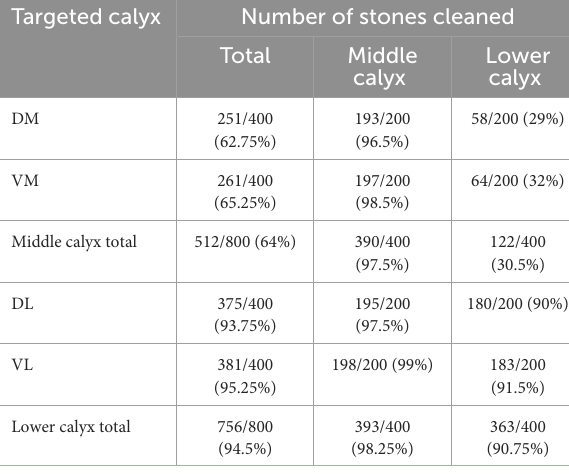
TABLE 1 Stone clearance rate of four targeted calyces. Targeted